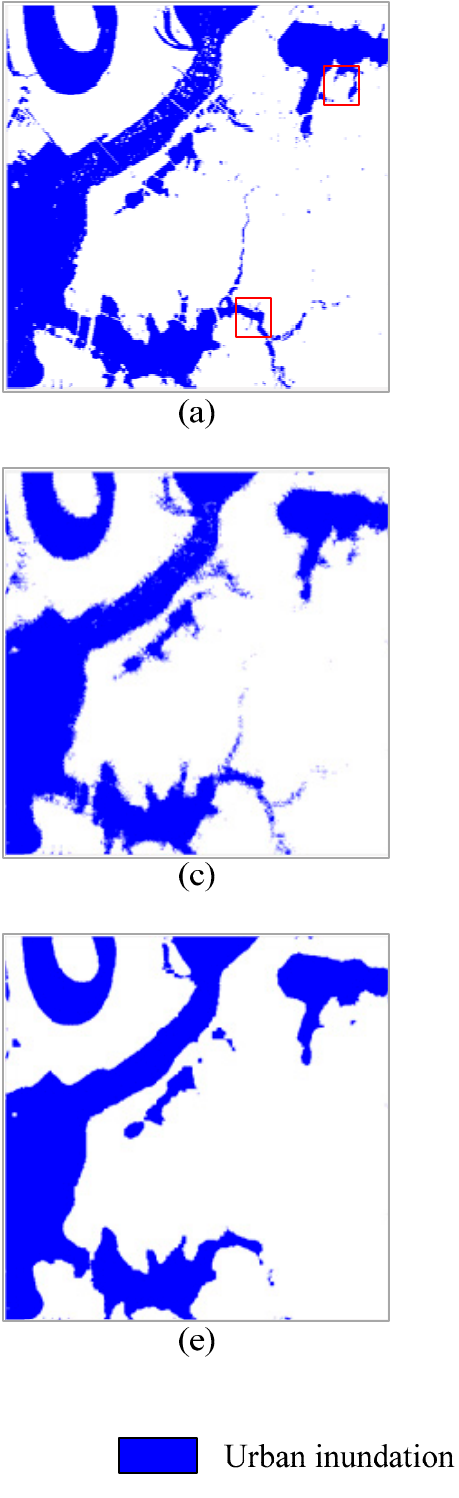
Figure 8. Experimental images and different SUIM results for Yueyang where red square shows the area for zooming. ( a ) Inundation reference image; ( b ) inundation fraction image; ( c ) BPNN ‐ SUIM; ( d ) SVM ‐ SUIM; ( e ) SAM ‐ SUIM; ( f ) SAMENN ‐ SUIM.